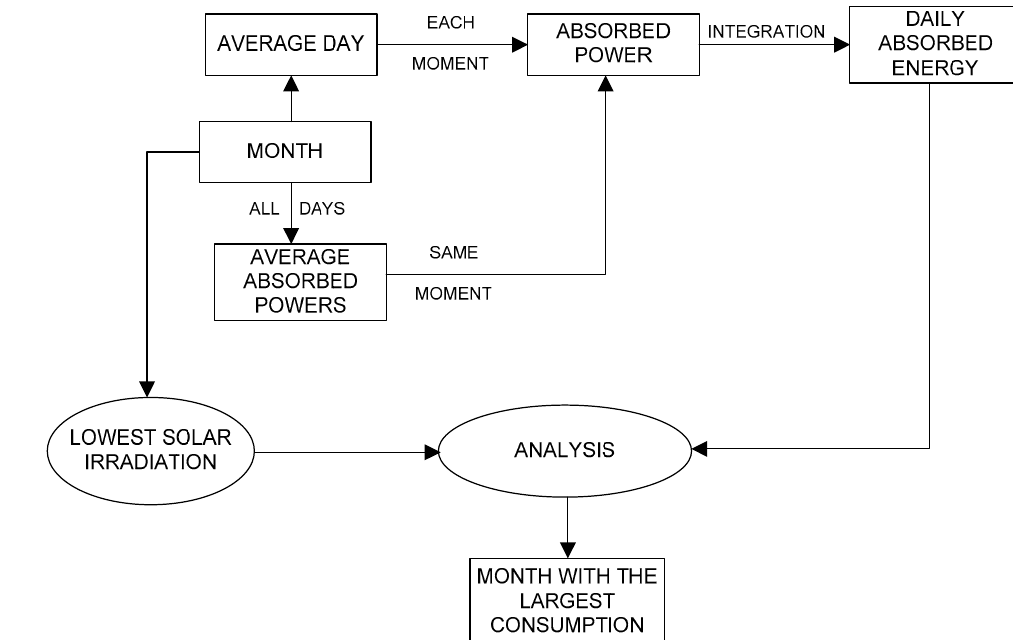
Figure 3. Flowchart of average day for consumed active power.